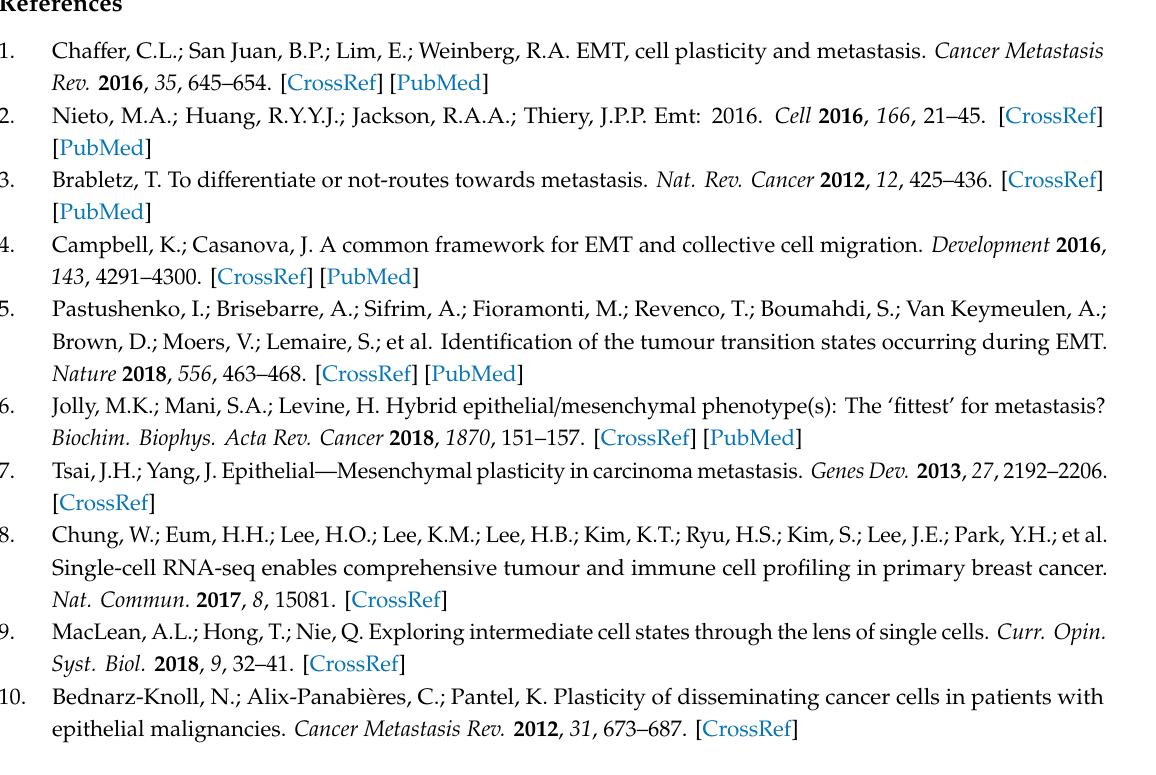
Table S1. Metastasis associated functional read-outs. Details pertaining to the setup, quantification, and biological read-out associated with the in vitro and in vivo methods employed to study the metastatic cascade are enlisted. Table S2. Applications and limitations of metastasis associated functional read-outs. Details pertaining to the cellular functionality gauged, stage of metastasis represented, and inherent limitations of the in vitro and in vivo methods employed to study the metastatic cascade are enlisted. Table S3. The real-time approach. Details pertaining to the model systems, relevant instrumentation, quantitative tools and variables, and their biological relevance for recent real-time studies are enlisted. The table includes a summary of a limited number of studies, interested readers may refer to the available literature cited in the text for more